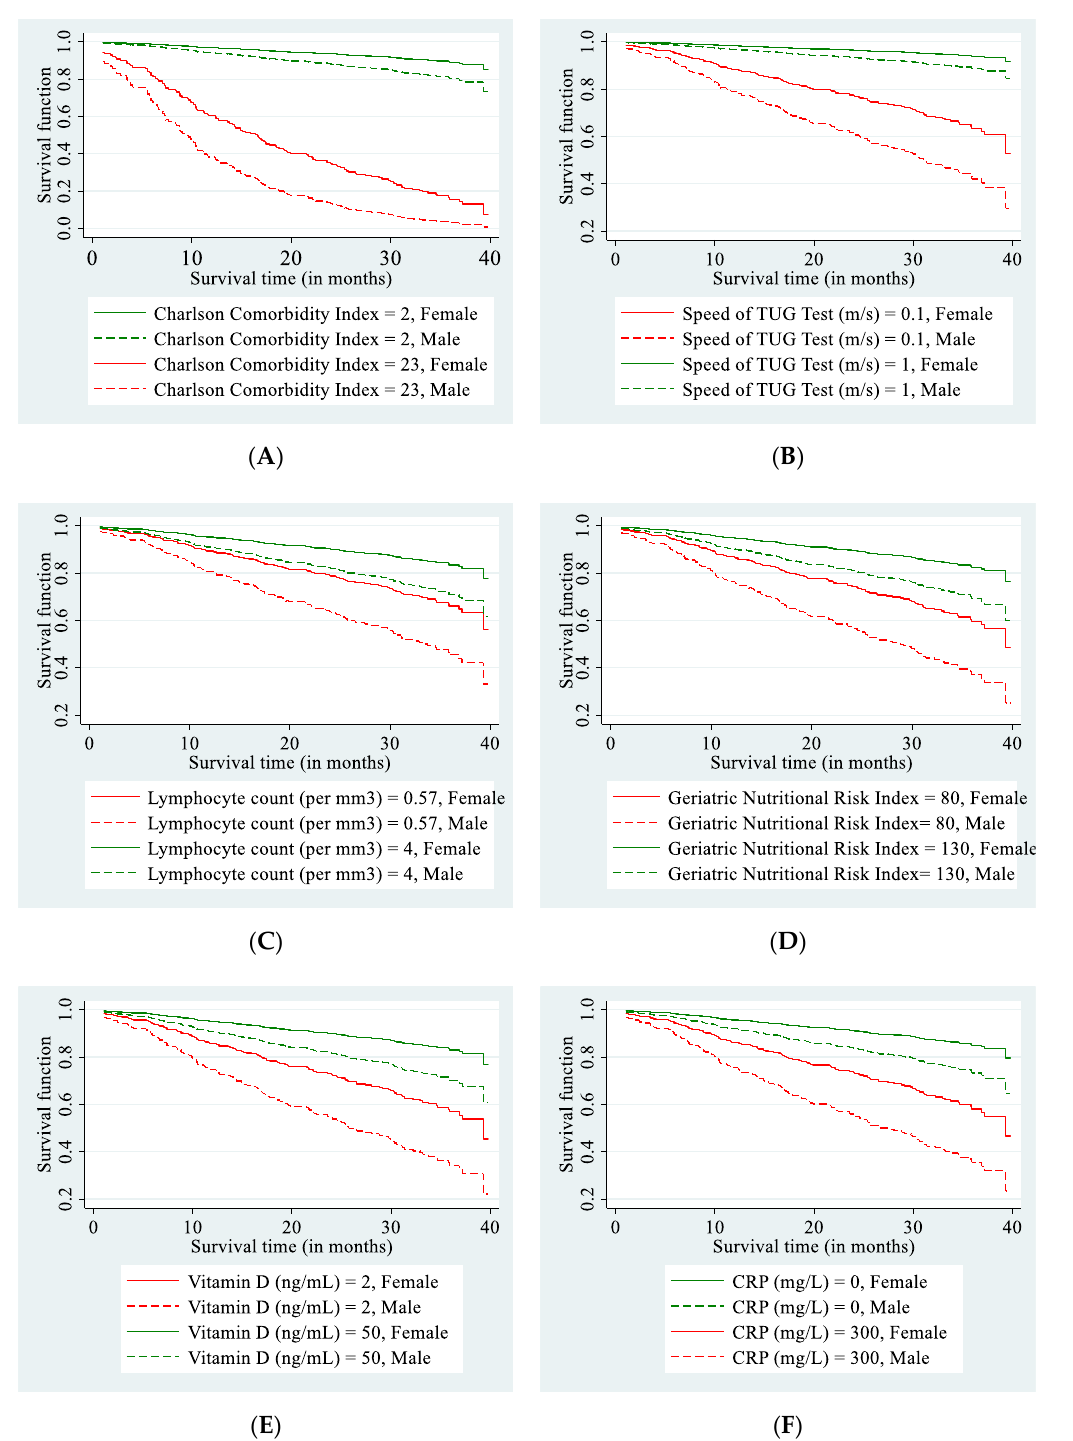
Figure 2. Survival curves for a geriatric patient depending on his or her sex and the selected health-related covariates identified using the stepwise backward variable selection approach (with p < 0.05): Age-weighted Charlson Comorbidity Index (panel A ), the speed of performing the Timed Up and Go (TUG) test (panel B ), total lymphocyte count (panel C ), Geriatric Nutritional Risk Index (panel D ), the vitamin D level (panel E ), and CRP level (panel F ). For each panel, the survival curves were derived from the multivariable Cox PH model for given sex and for selected very low or very high values of one explanatory variable, whereas the values of remaining covariates in the model were set at their average level.